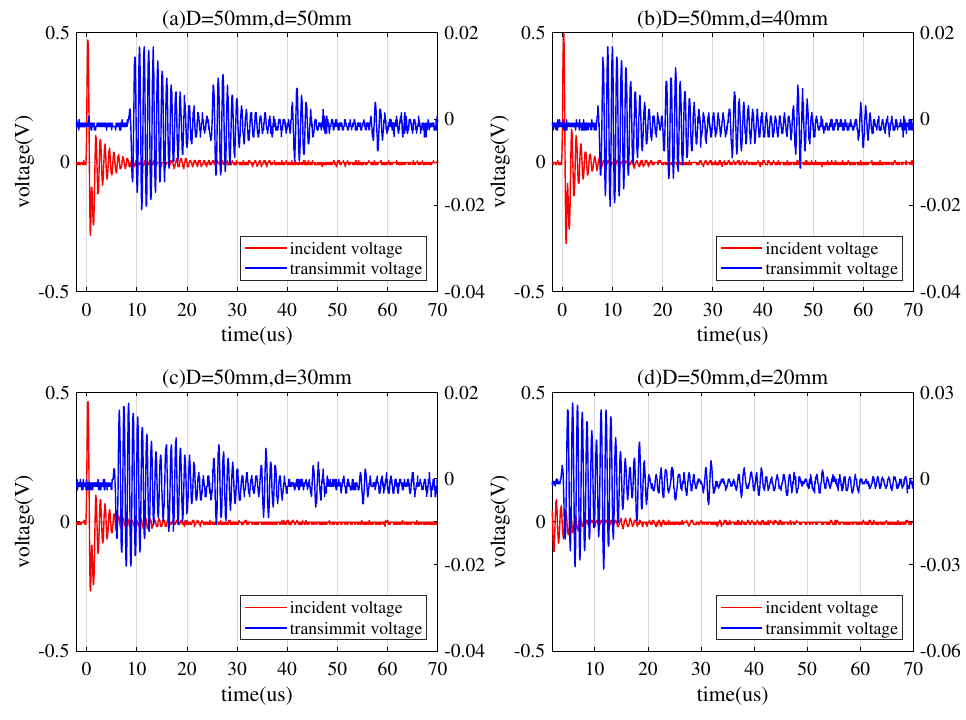
Figure 13. Pulse response with different barrier